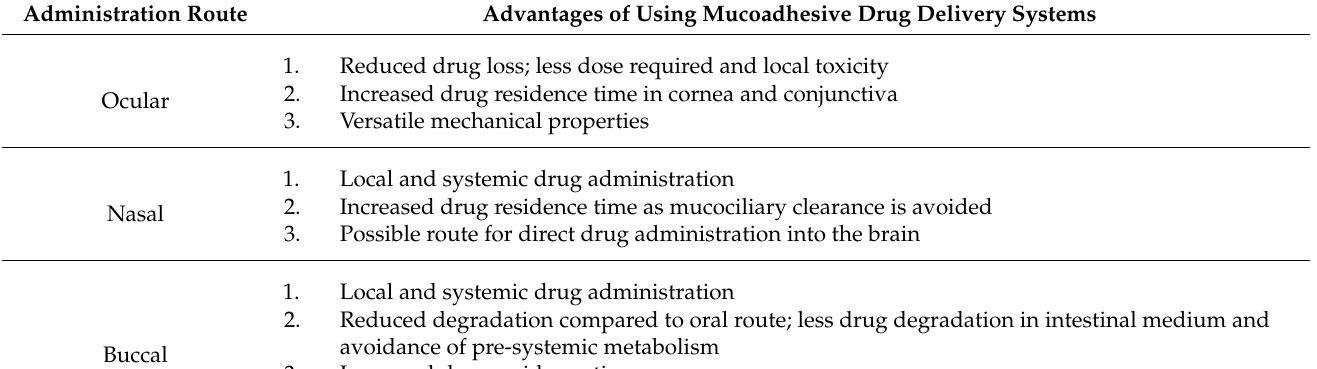
Table 2. Advantages of using mucoadhesive drug delivery systems for different administration routes. Administration